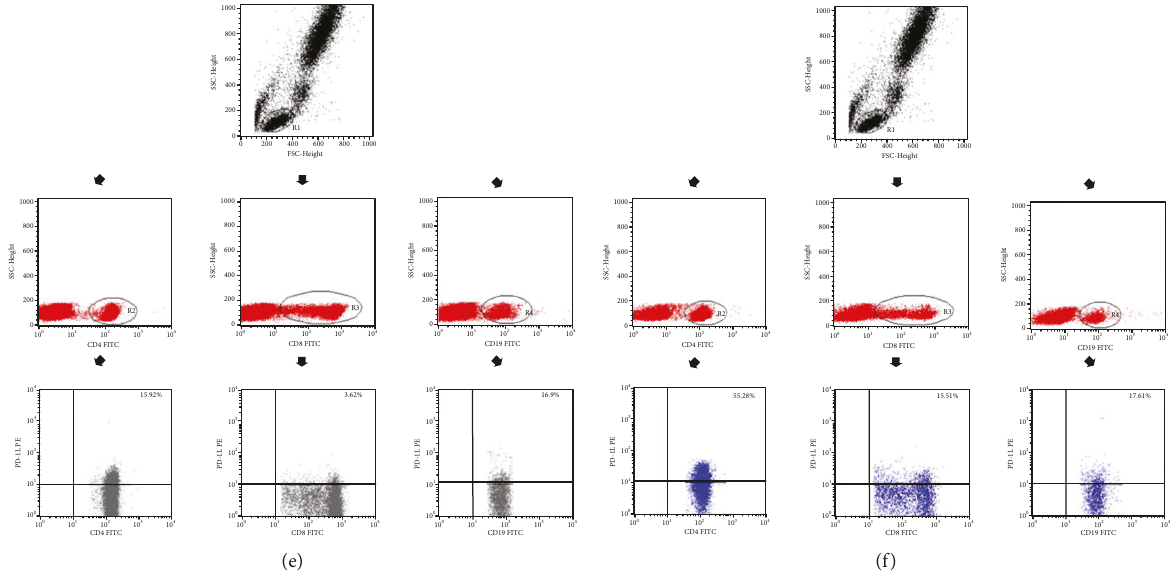
Figure 1: (a) Sample analysis of the expression of PD-1 + on CD4 + T, CD8 + T, and CD19 + B lymphocytes in a healthy individual. (b) Sample analysis of the expression of PD-1 + in CD4 + T, CD8 + T, and CD19 + B lymphocytes in a stage I endometriosis patient. (c) Sample analysis of the expression of PD-1 + in CD4 + T, CD8 + T, and CD19 + B lymphocytes in a stage IV endometriosis patient. (d) Sample analysis of the expression of PD-L1 + in CD4 + T, CD8 + T, and CD19 + B lymphocytes in a healthy individual. (e) Sample analysis of the expression of PD-L1 + in CD4 + T, CD8 + T, and CD19 + B lymphocytes in a stage I endometriosis patient. (f) Sample analysis of the expression of PD-L1 + in CD4 + T, CD8 + T, and CD19 + B lymphocytes in a stage IV endometriosis